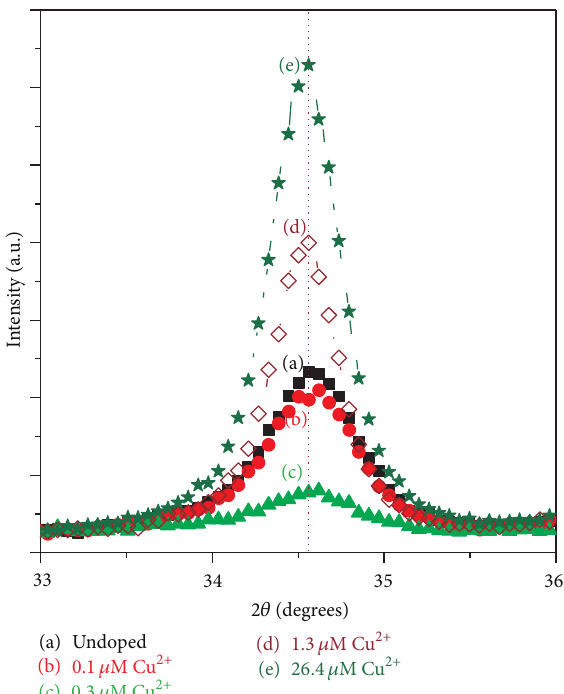
Figure 2: Peak intensity of (002) plane in doped ZnO films with different concentrations of Cu doping. (a) ZnO, (b) 0.1 𝜇 M Cu 2+ , (c) 0.3 𝜇 M Cu 2+ , (d) 1.3 𝜇 M Cu 2+ , and (e) 26.4 𝜇 M Cu 2+ concentrations.